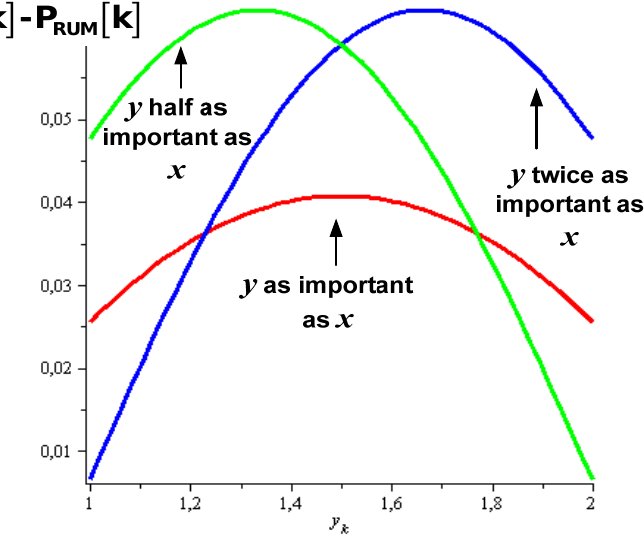
Figure A3. How RRM captures compromise